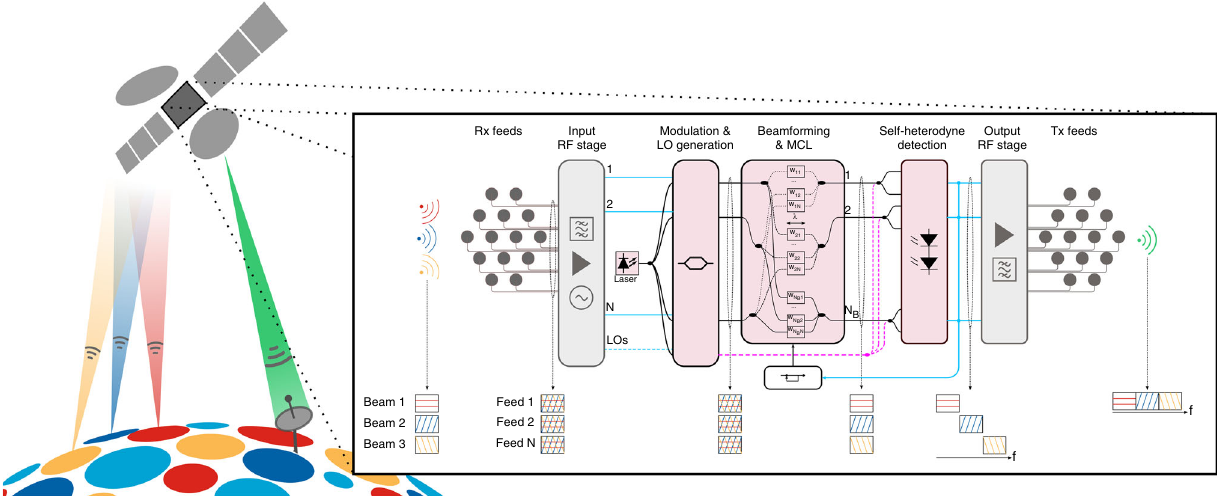
Fig. 1 Photonic-aided payload receiver. User beams are received by the satellite, aggregated by the payload and re-transmitted to a ground station connected to the World Wide Web. Inset: the photonic-aided payload receiver up-converts the signals provided by the receiving feeds to optical signals, separates all beams via beamforming, and down-converts the separated beams back to radio frequency (RF) signals at the right frequency to be re- transmitted to a ground station by means of heterodyning. A monitoring and control loop (MCL) is used to operate, optimize and stabilize the optical beamforming network